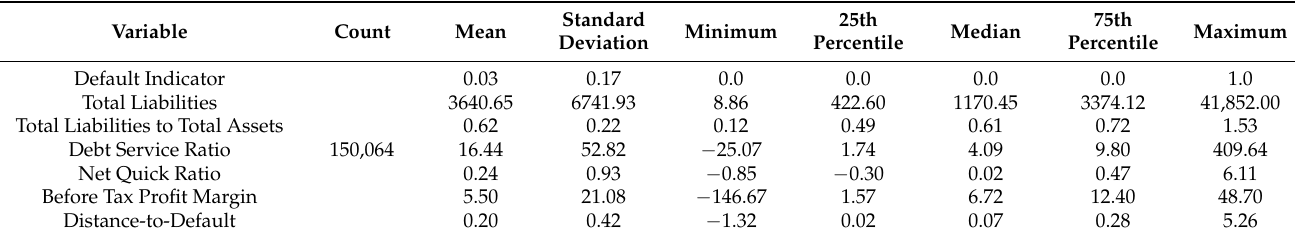
Table 6. Summary Statistics—Moody’s Large Corporate Financial and Merton/Structural Model Distance-to-Default Proxy Measure Explanatory Variables and Default Indicators: 3-Year TTC Model 2.